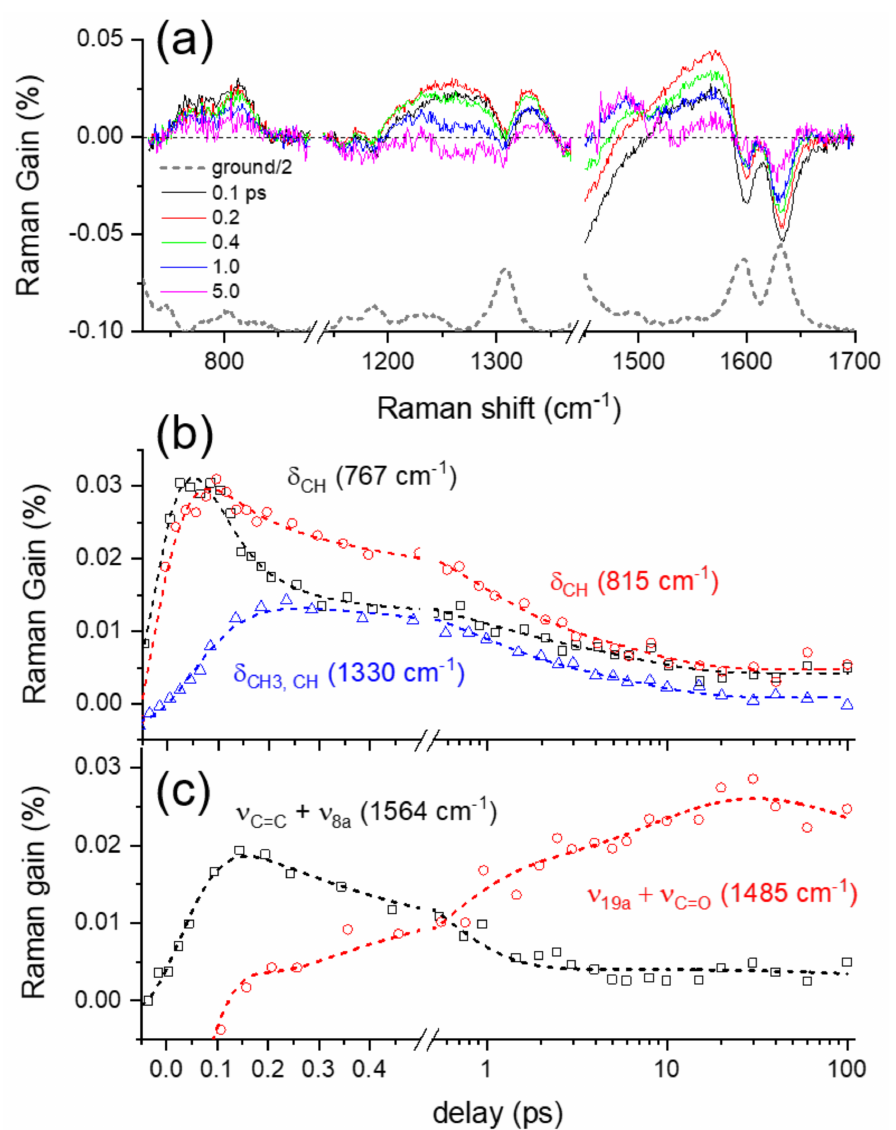
Figure 4. ( a ) Excited-state Raman spectra of curcumin obtained from FSRS measurements with 403 nm excitation and the ground-state Raman spectrum ( b ), ( c ) population dynamics of the major vibrational modes of curcumin in the S 1 /LE and S 1 /CT states. Open symbols represent the experimental data and dotted lines represent the fit